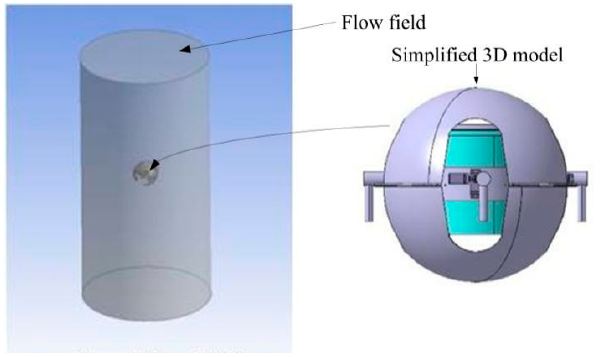
Figure 13. Flow field of SURIII.